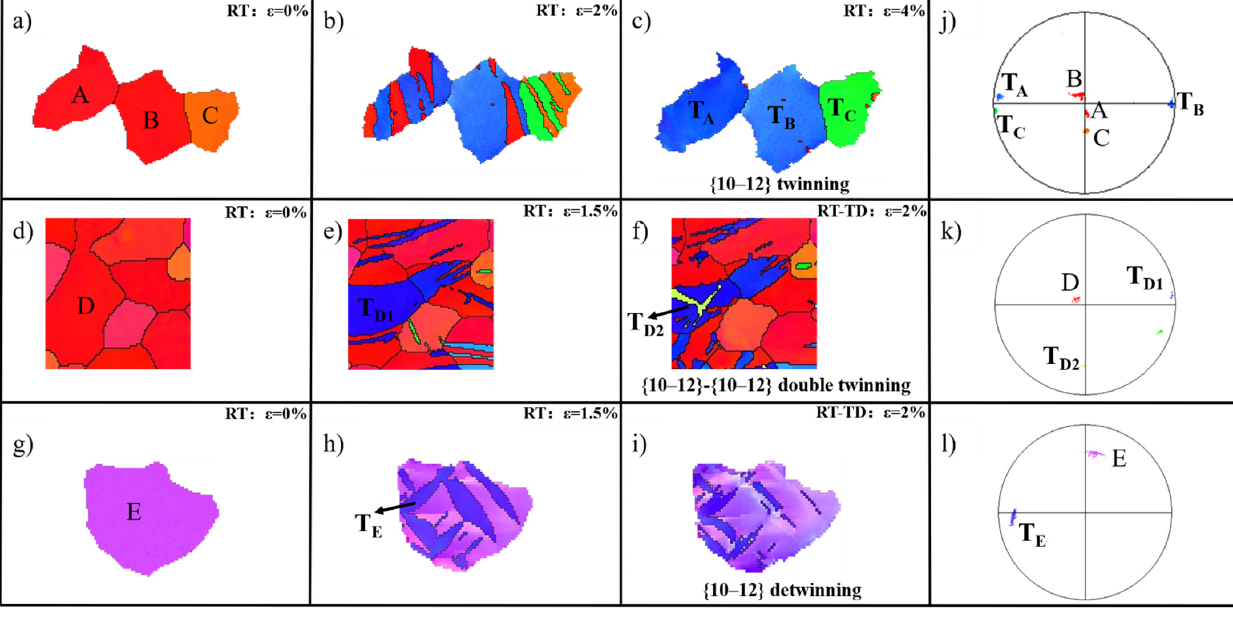
Figure 3. ( a – i ) In situ EBSD maps for selected grains at different strain levels; ( j – l ) crystallographic orientation of the selected grains and twin lamellae. orientation of the selected grains and twin